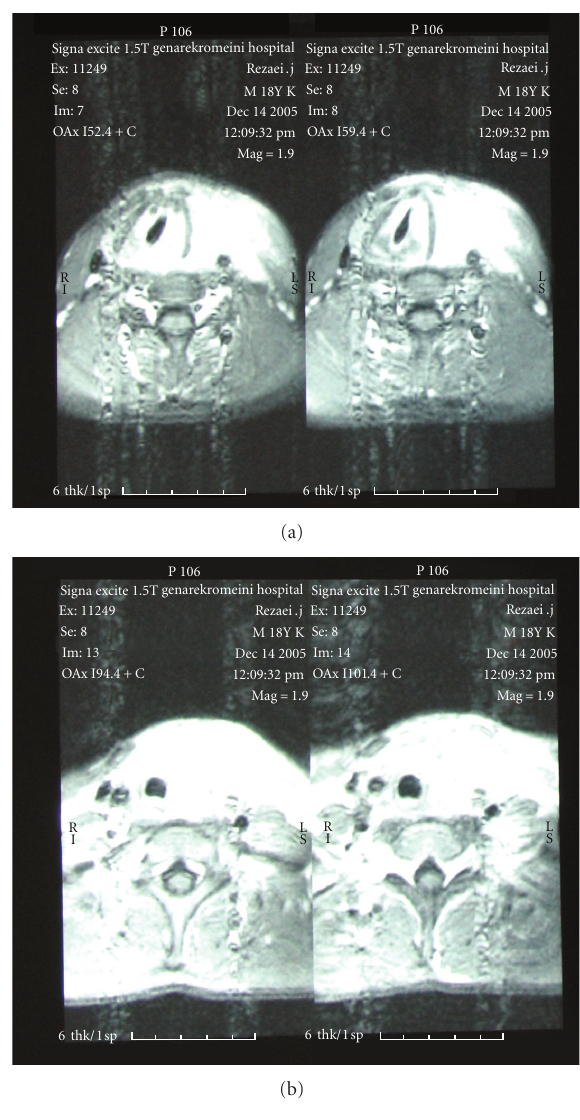
Figure 3: MRI findings in the second